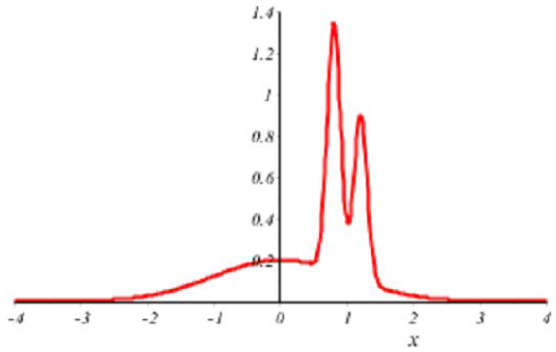
Figure 1. Trimodal density function.